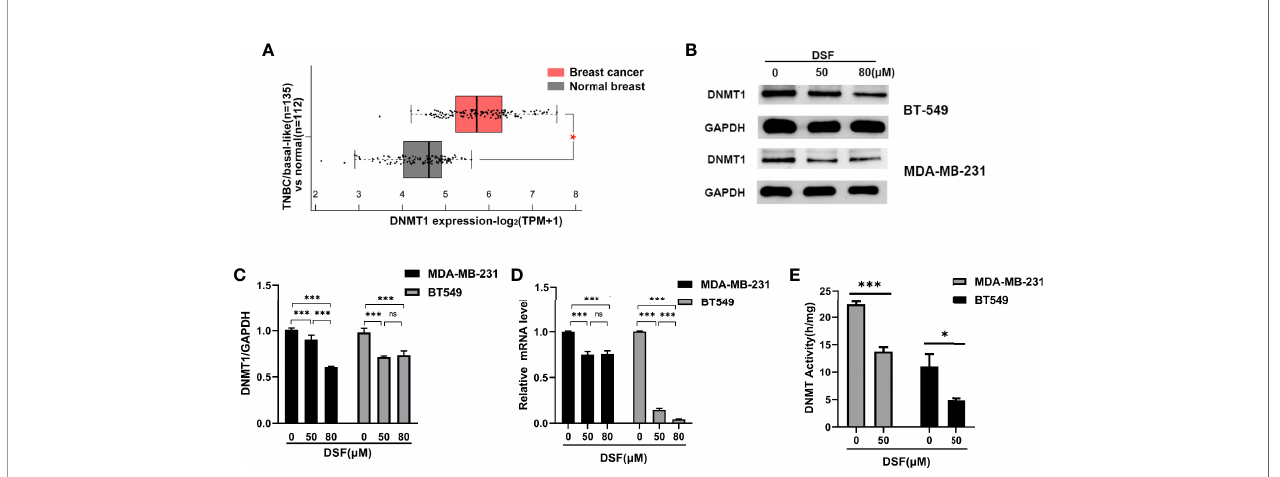
FIGURE 1 | DSF inhibits DNMT1 expression and activity in vitro . (A) Gene expression analysis of DNMT1 using GEPIA2 database based on the TCGA database. Box plots represent the gene expression level in terms of log2 (TPM+1) in the tumor (TNBC/basal-like subtype, red, n=135) and normal breast tissue (gray, n=112) samples, respectively. (B) DNMT1 expression in human BT-549 and MDA-MB-231 cells by Western blotting after treatment with different doses of DSF for 48 h. (C) Quantitative analysis of DNMT1 expression after different doses of DSF for 48 h through ImageJ intensity measurements. (D) The relative mRNA expression levels of DNMT1 in human MDA-MB-231 cells and BT-549 cells treated with indicated concentration of DSF for 48 h. (E) DNMT1 enzyme activity assays in human MDA- MB-231 and BT-549 cells treated with indicated concentration of DSF for 48 h. *p < 0.05, ***p < 0.001. ns, no statistic signi fi